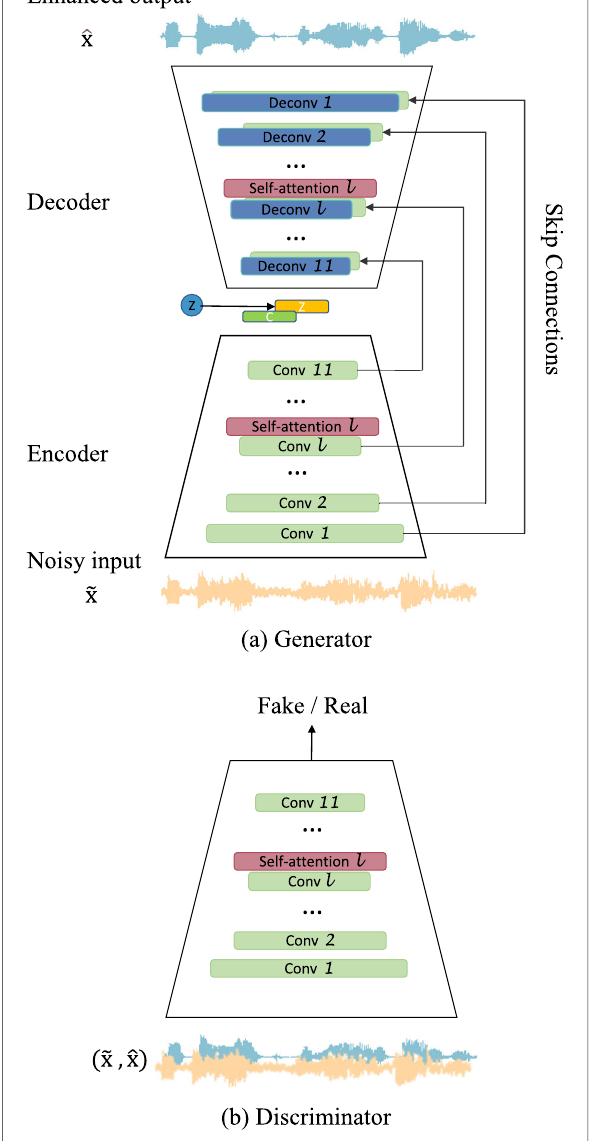
Fig. 3 Illustration of the SA_SEGAN architecture. a The generator component. b The discriminator component